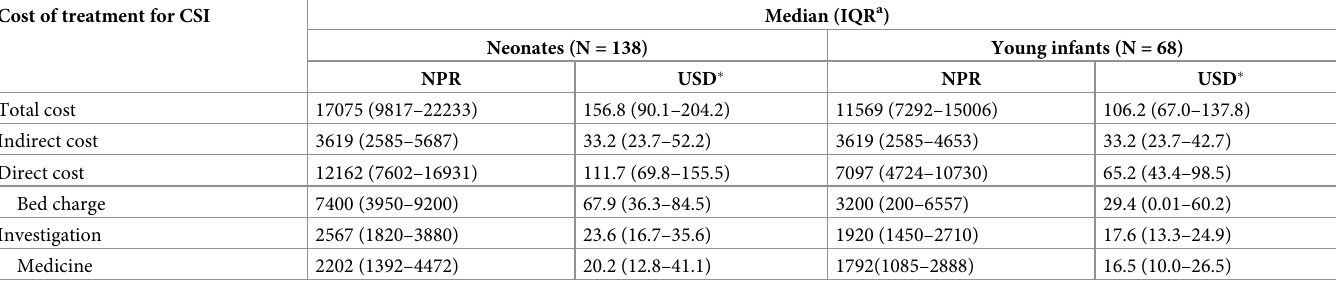
Table 2. Median costs for treatment of clinical severe infection in study participants at Kanti Children’s Hospital.